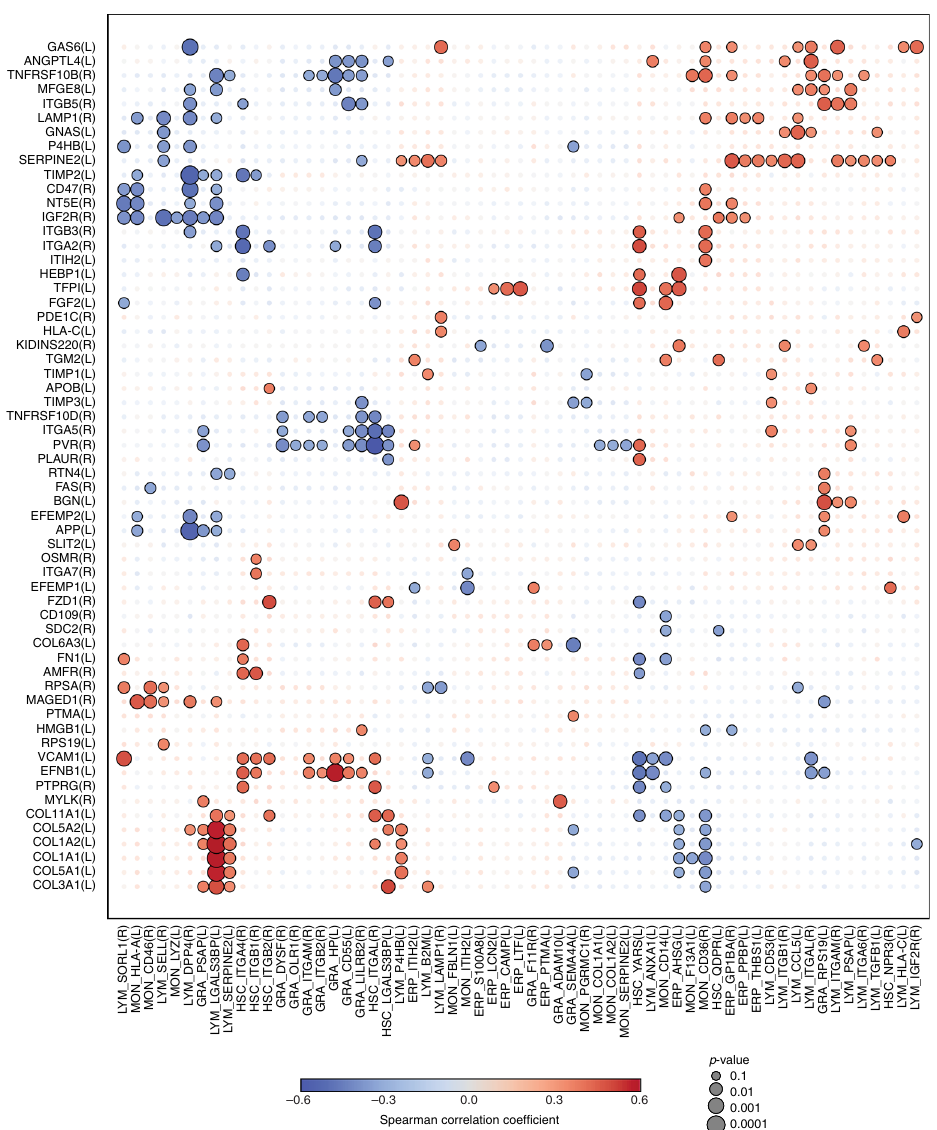
Fig. 9 Coordinated alterations occur across the different subpopulations upon ageing. Correlation matrix (Spearman) for extracellular protein – ligand receptor pairs at the interface between MSCs and all other cell populations (see Methods). MSC ligands (L) and MSC receptors (R) altered upon ageing ( p value < 0.1, Spearman's correlation) on the y -axis have at least one correlation value with altered receptors (R) or ligands (L) quanti fi ed in the other cell populations with a p value < 0.1, Spearman's correlation. The colour indicates positive or negative correlation and the size of the circle is reciprocal to the associated p value. Correlation coef fi cients with p values ≥ 0.1 are depicted as transparent. Unsupervised clustering using Euclidean distances and the complete clustering method was performed on both